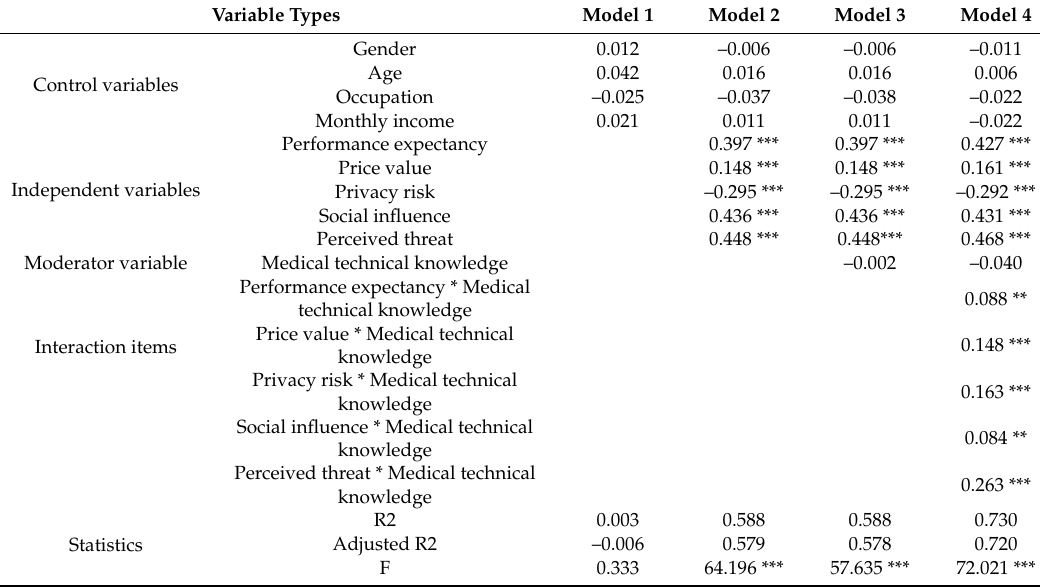
Table 5. Hypothesis